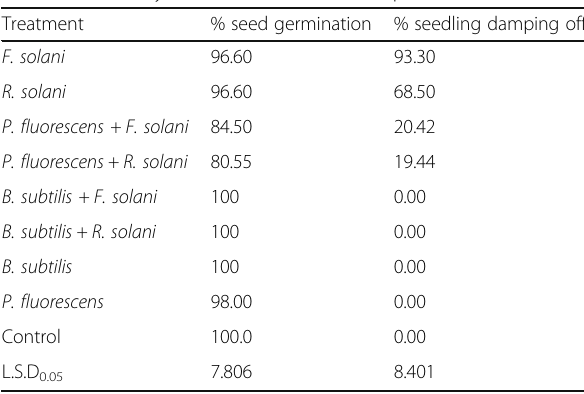
Table 4 Effect of B. subtilis and P. fluorescens on damping-off disease caused by F. solani and R. solani in pots